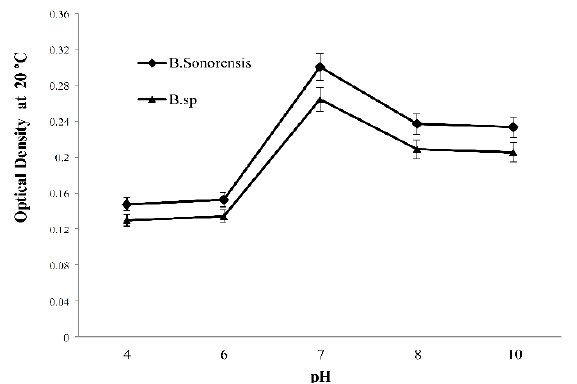
Fig. 2. Growth (optical density) of B. Sonorensis and B . sp. at 20 °C in different pHs (48 h)